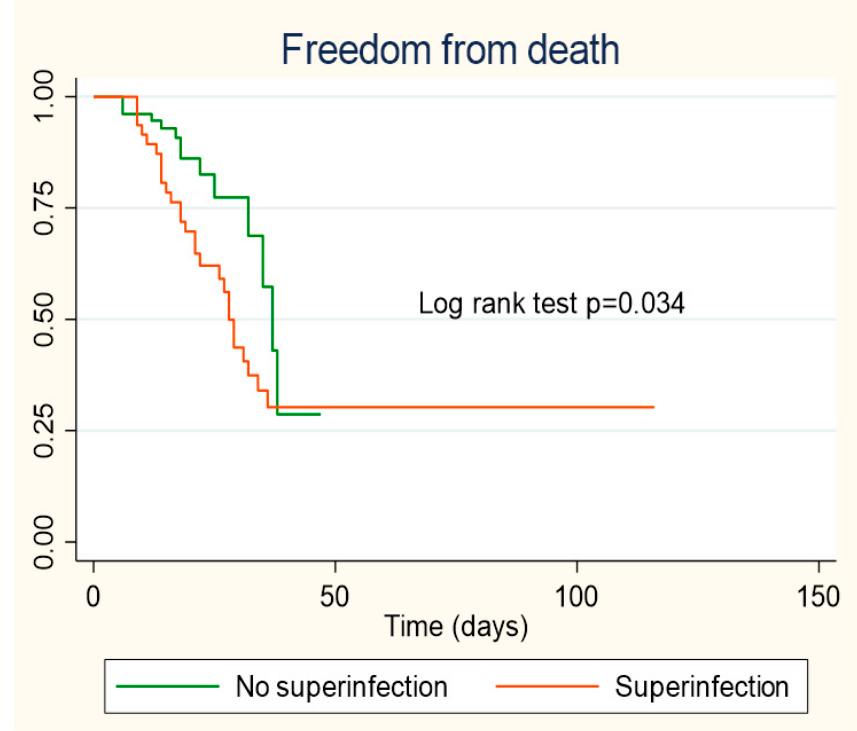
Figure 2. Kaplan–Meier survival curves according to healthcare-associated infection.